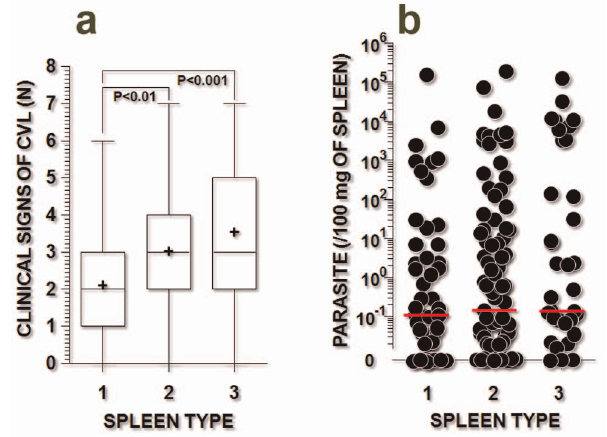
Figure 2. Clinical signs of visceral leishmaniasis and parasite burden in dogs with active (positive spleen culture) or quiescent (negative spleen culture) infection by Leishmania infantum , with different levels of disorganization of the splenic white pulp. a) frequency of clinical signs associated with visceral leishmaniasis (alopecia, anemia, conjunctivitis, dermatitis, emaciation, lymphadenopathy, and onychogryphosis); b) parasite burden in the spleen, as estimated by qPCR (see details in the text). The spleen types include spleen type 1 (organized) and type 3 (moderately to severely disorganized). The Kruskal-Wallis statistical test was used.